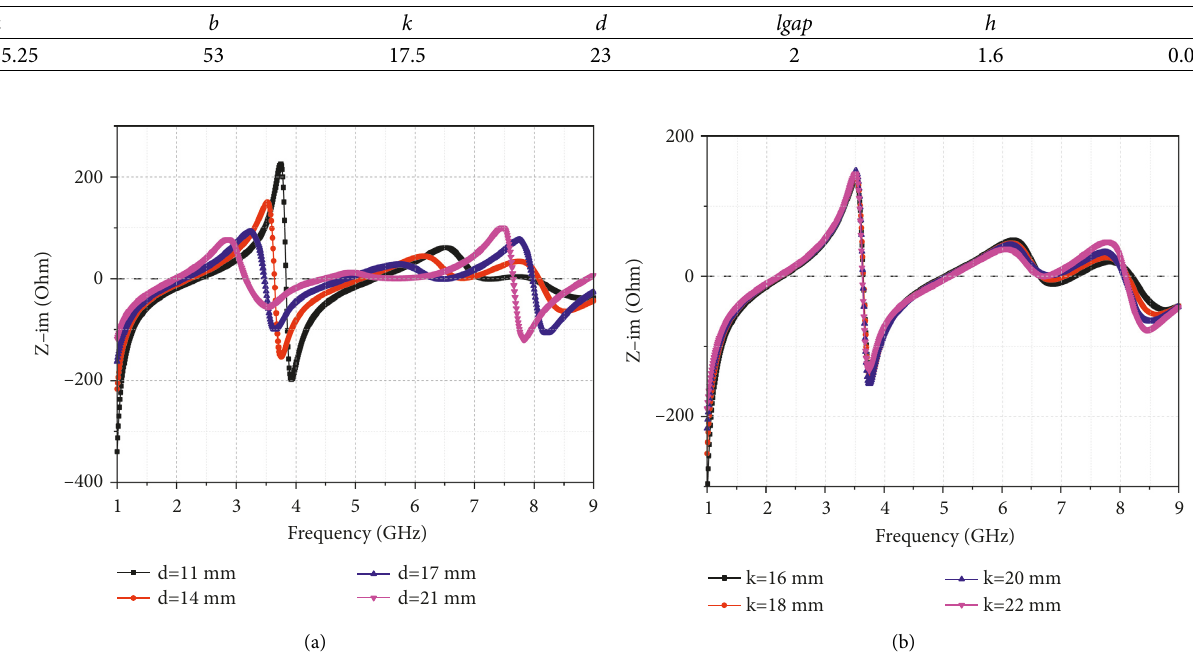
Figure 1: The geometry of antenna 1 with the conventional structure. Table 1: Parameters of antenna 1 (mm).